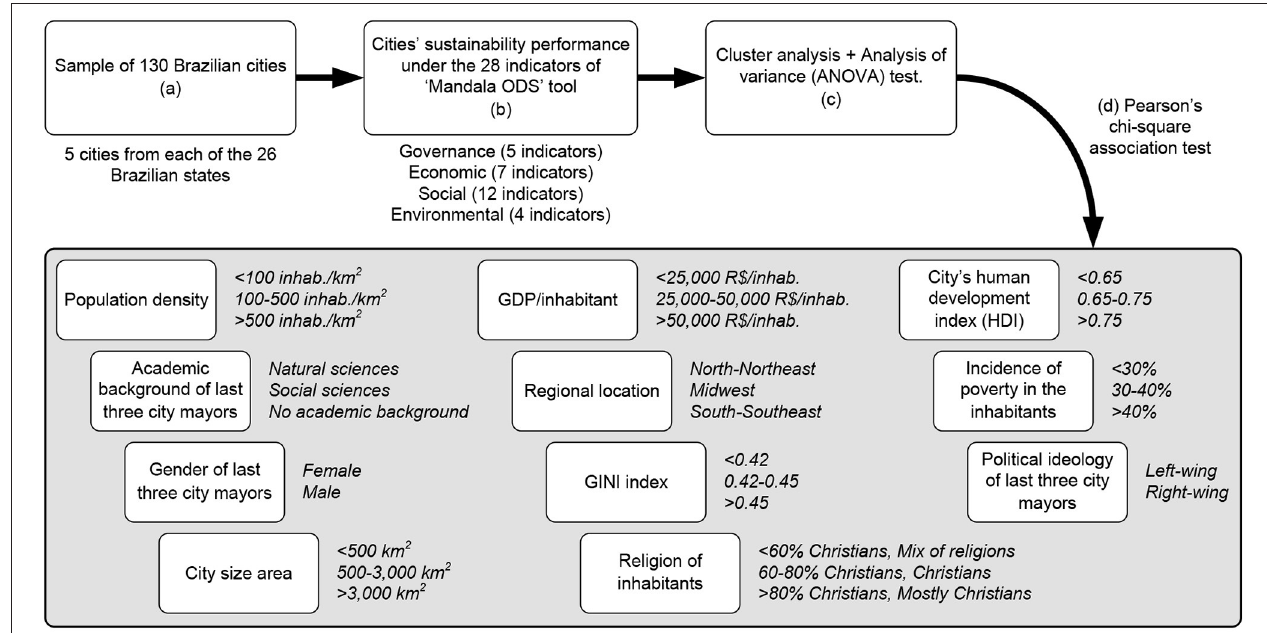
FIGURE 1 | Schematic representation of the methodological steps applied in this study: (a) sample choice, (b) gathering data from the “Mandala ODS” for the sample chosen, (c) cluster analysis and verification of its quality from ANOVA test, and (d) association test among variables (within the larger gray rectangle) and clusters. Due to reduced page numbers allowed for this perspective letter, raw data is exclusively available through direct correspondence with first author.